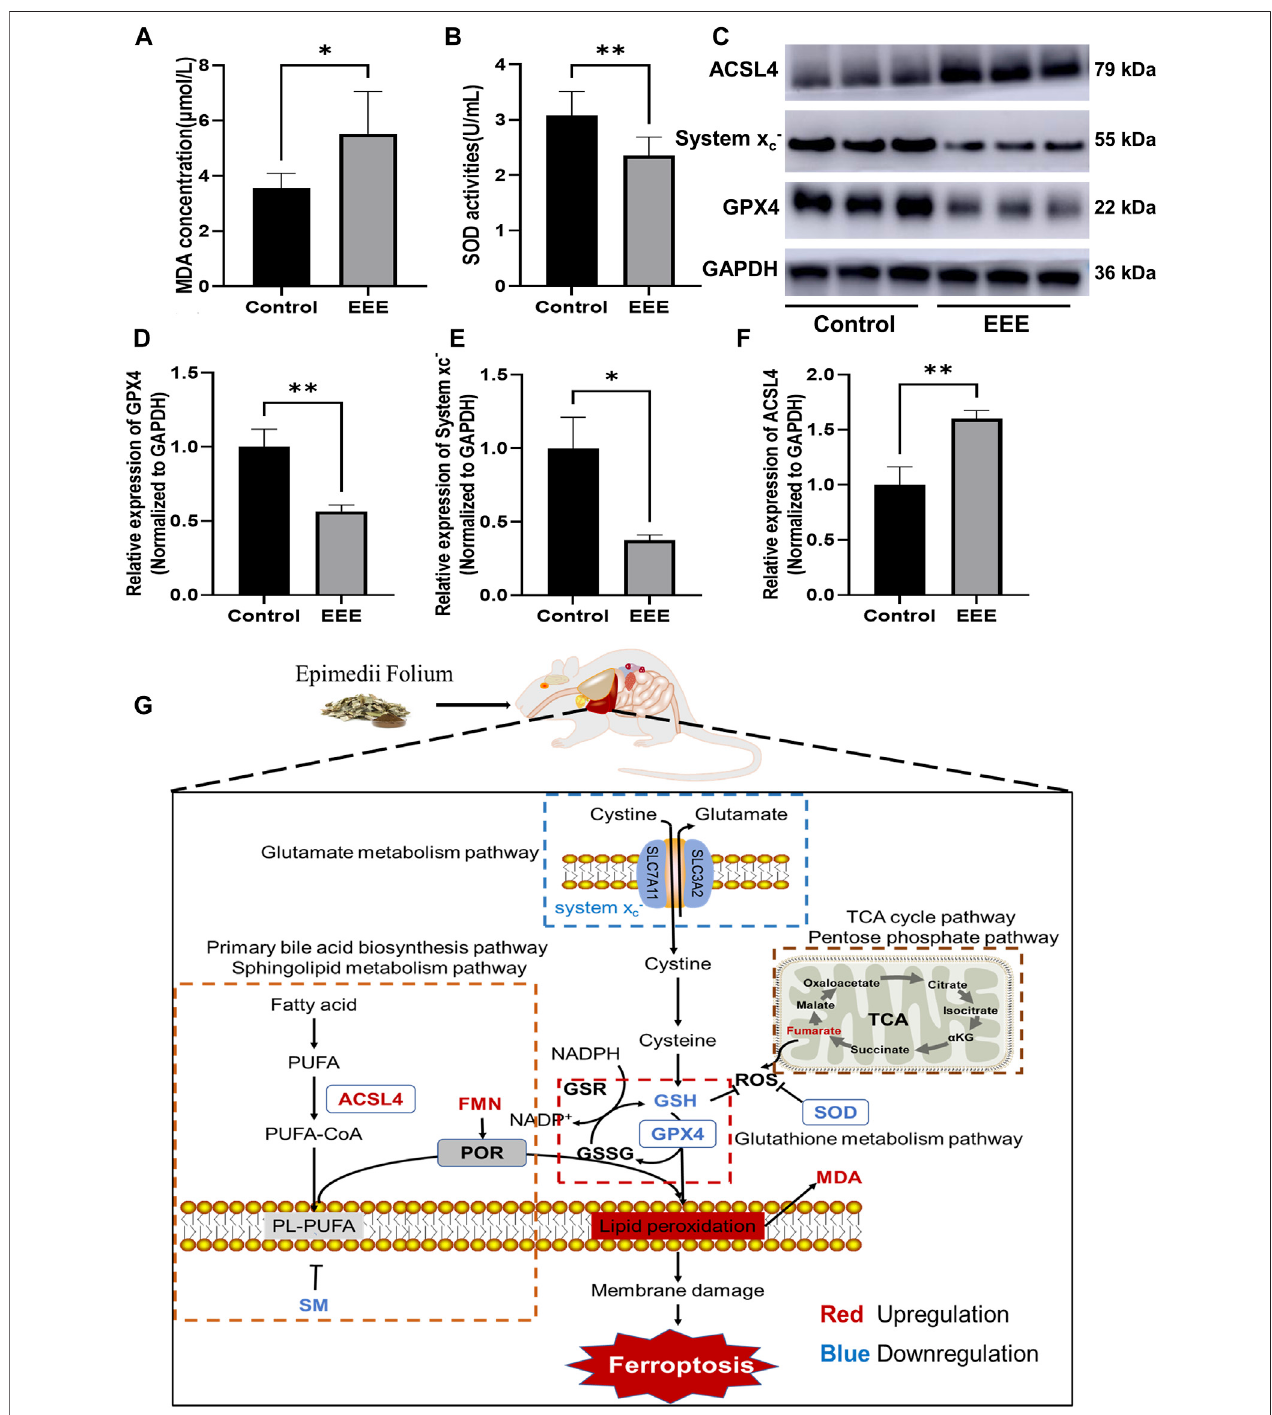
FIGURE 6 | Changes of ferroptosis markers in rat liver after EEE exposure. (A) The MDA contents were signi fi cantly higher than in the control group. (B) The SOD activity wassigni fi cantlylower than thecontrol group. (C) Theprotein contentofGPX4, Systemx c − , and ACSL4intheliverwasdetected byimmunoblotting. Results are presentedasmean±SDinrats,andsigni fi cantdifferencesareindicated( p p < 0.05, pp p < 0.01vs. Controlgroup, n =6). (D) AfterEEEexposure,theexpressionofGPX4 protein was signi fi cantly lower than in the control group. (E) After EEE exposure, the expression of System x c − protein was signi fi cantly lower than in the control group. (F) AfterEEEexposure,theexpressionofACSL4proteinwassigni fi cantlyhigherthaninthecontrolgroup. (G) MechanismofEEE-inducedliverinjurybytriggering ferroptosis based on metabolomic analysis.